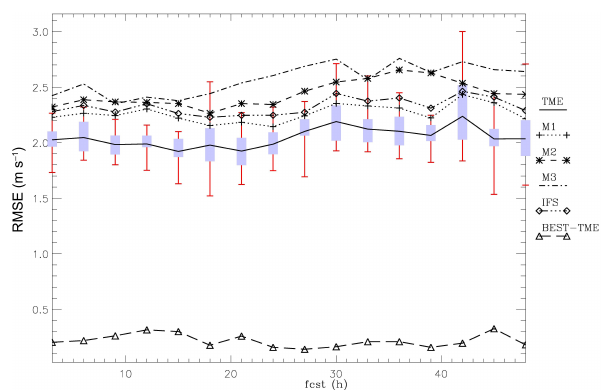
Figure 6. Winter RMSE for the wind speed after bias elimination. The difference between the RMSE of the best model (depending on the forecast time) and that of the TME is also shown (BEST-TME).